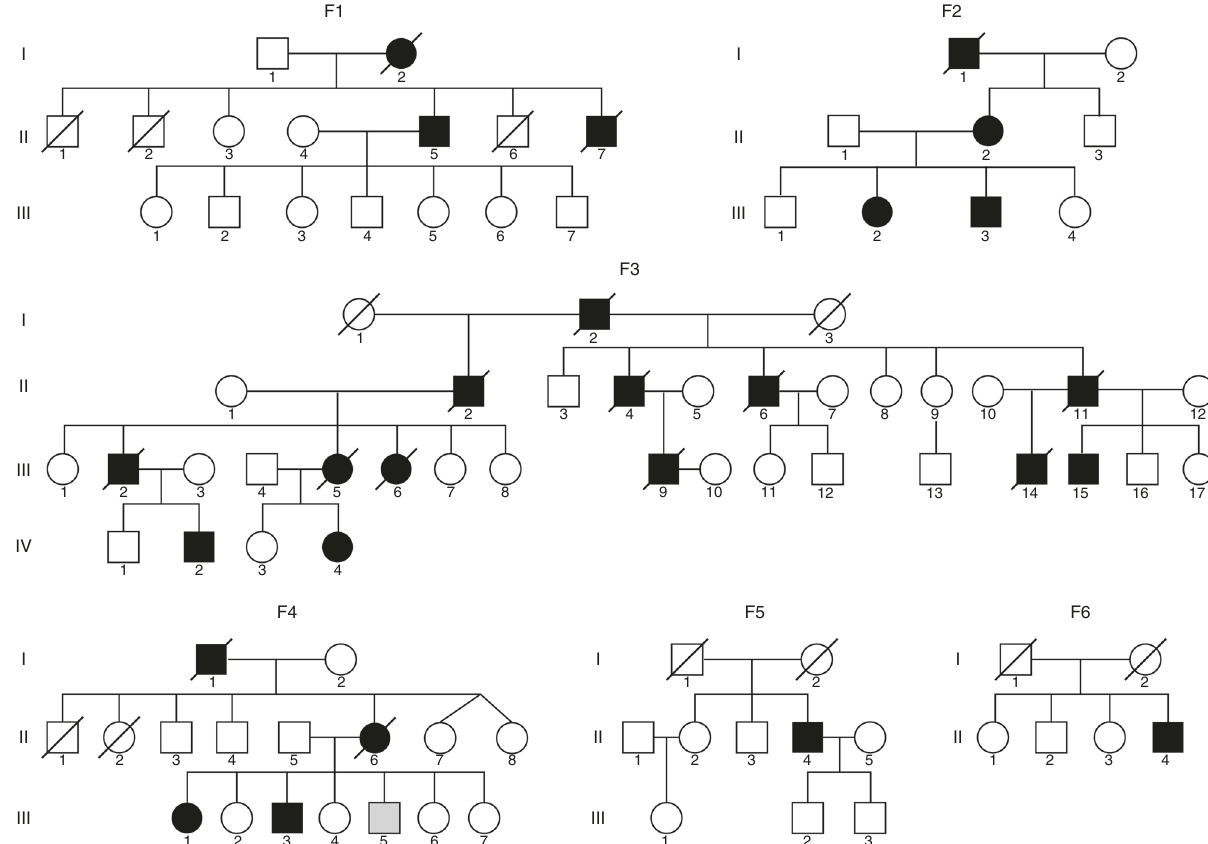
Fig. 1 Pedigrees from the six families affected with myoglobinopathy. F1 and F2 Spanish, F3: Swedish, F4 and F5: French, F6: Dutch. Squares represent males; circles, females; fi lled black symbols indicate affected individuals; fi lled gray symbol, clinically affected, but not molecularly tested individuals; and slash,